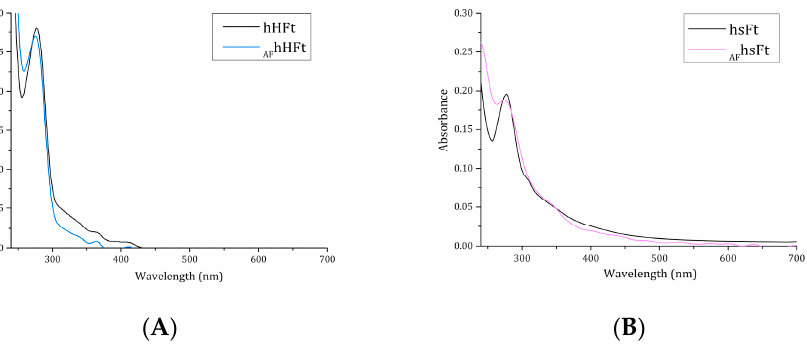
Figure 3. UV–vis spectra of AF hHFt (( A ), light blue line) and AF hsFt (( B ), pink line) in comparison to the spectra of the respective gold-free proteins (black lines).